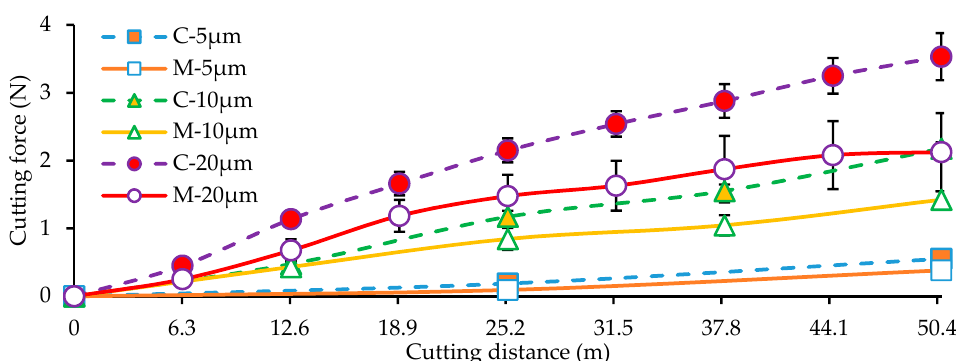
Figure 6. Diamond cutting tool flank wear and the corresponding machined surface quality of iron after cutting a total distance of 50.66 m under different feeds: ( a ) conventional; and ( b ) with the mechanochemical effect.